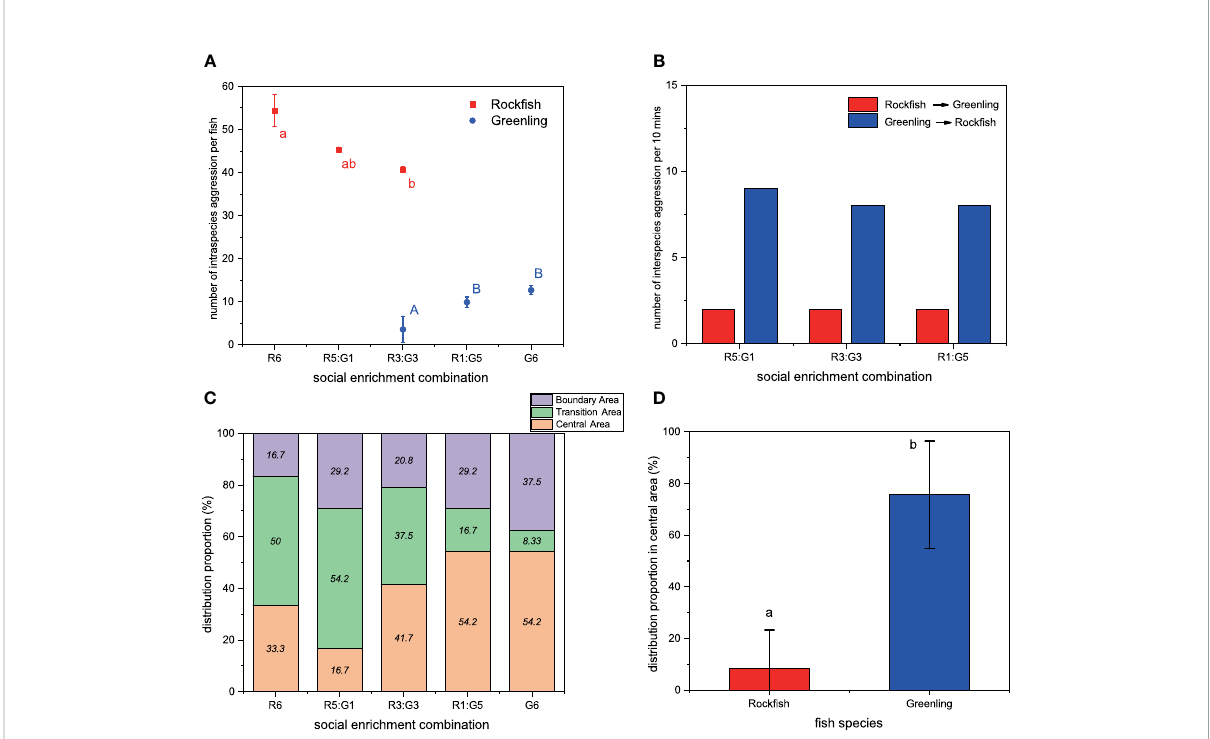
FIGURE 3 The aggressive behavior and group distribution of black rock fi sh and fat greenling from different social enrichment combinations during one-week rearing. (A) intraspecies aggression ( n = 3), (B) interspecies aggression ( n = 3), (C) distribution proportion in three areas ( n = 120), (D) distribution proportion in the central area ( n = 120). For plot (A) , different red, small letters indicate signi fi cant differences among social enrichment combinations within black rock fi sh, and different blue, capital letters indicate signi fi cant differences among social enrichment combinations within fat greenling. For plots (A) , (B) and (C) , R6 means 6 rock fi sh per aquarium, R5:G1 means 5 rock fi sh and 1 greenling per aquarium, R3:G3 means 3 rock fi sh and 3 greenling per aquarium, R1:G5 means 1 rock fi sh and 5 greenling per aquarium, and G6 means 6 greenling per aquarium. For plot (B) , ‘ Rock fi sh points to Greenling ’ means the frequency of aggression from black rock fi sh to fat greenling, and ‘ Greenling points to Rock fi sh ’ means opposite context. For plot (D) , different letters indicate signi fi cant differences between the two fi sh species. Data are presented as means ±